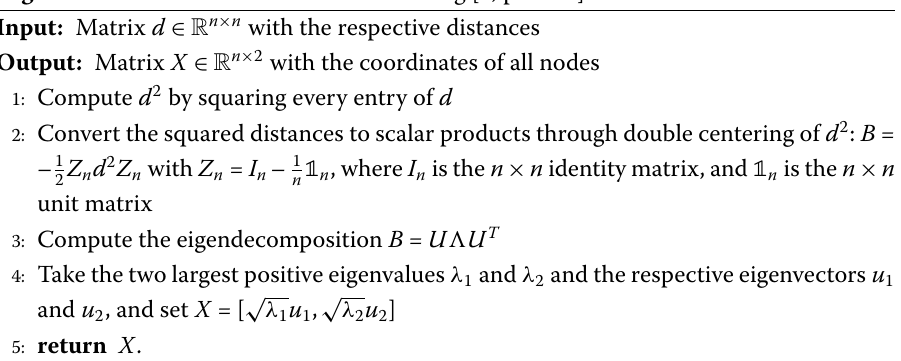
Algorithm 2 Classic multidimensional scaling [4, p.